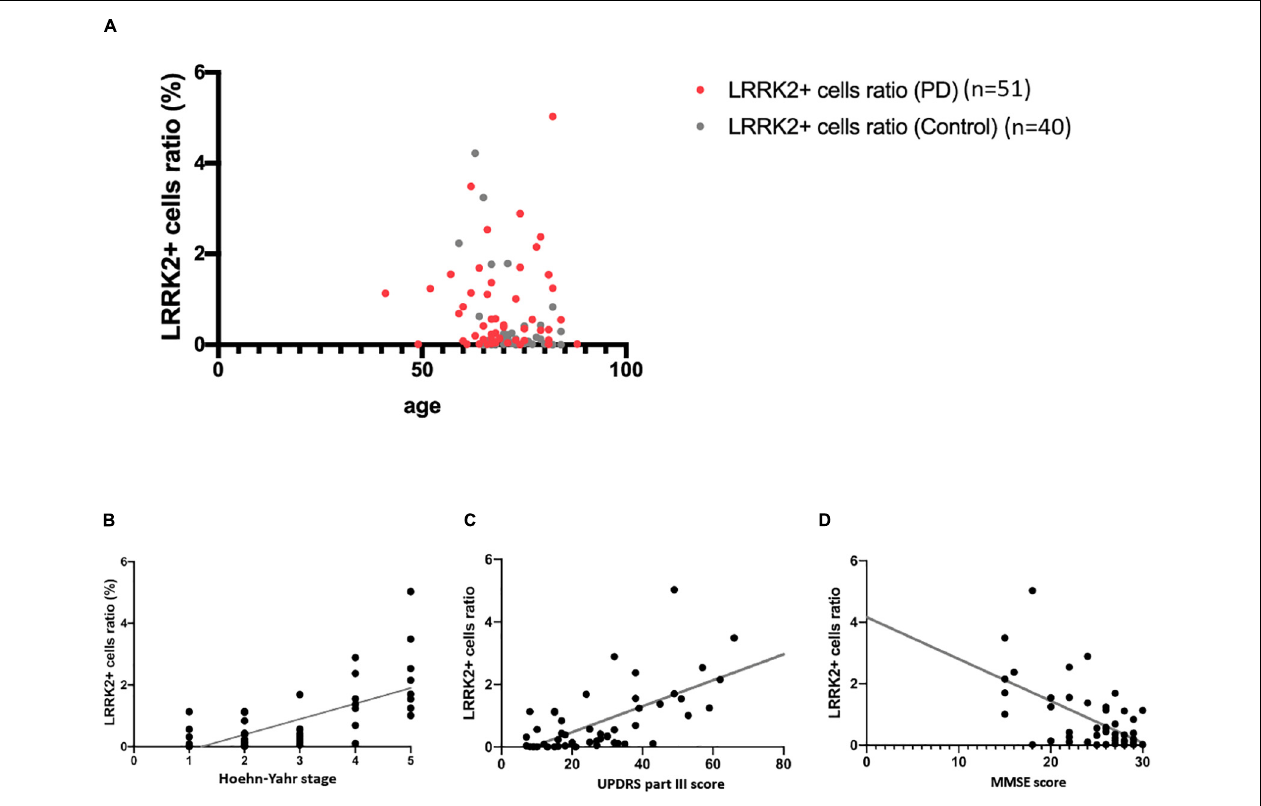
FIGURE 2 | Correlation of colonic LRRK2 expression with clinical severity in PD. (A) Age did not correlate with LRRK2 expression in colonic biopsies. (B,C) Correlation of colonic LRRK2 expression with Hoehn-Yaht stage and UPDRS part III motor score. (D) Correlation of colonic LRRK2 expression with MMSE score.